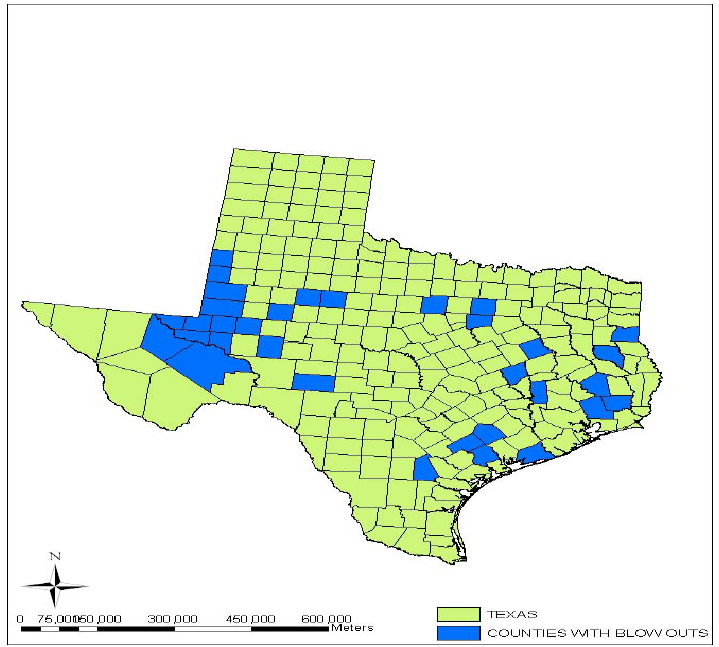
Figure 13. Blowout Occurrences in the Counties of Texas.